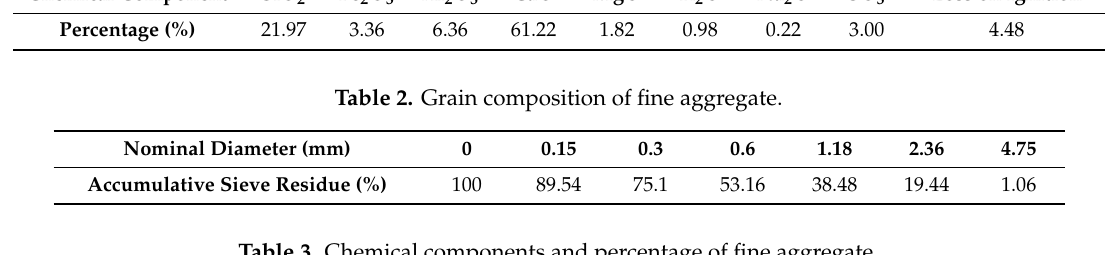
Table 3. Chemical components and percentage of fine aggregate.